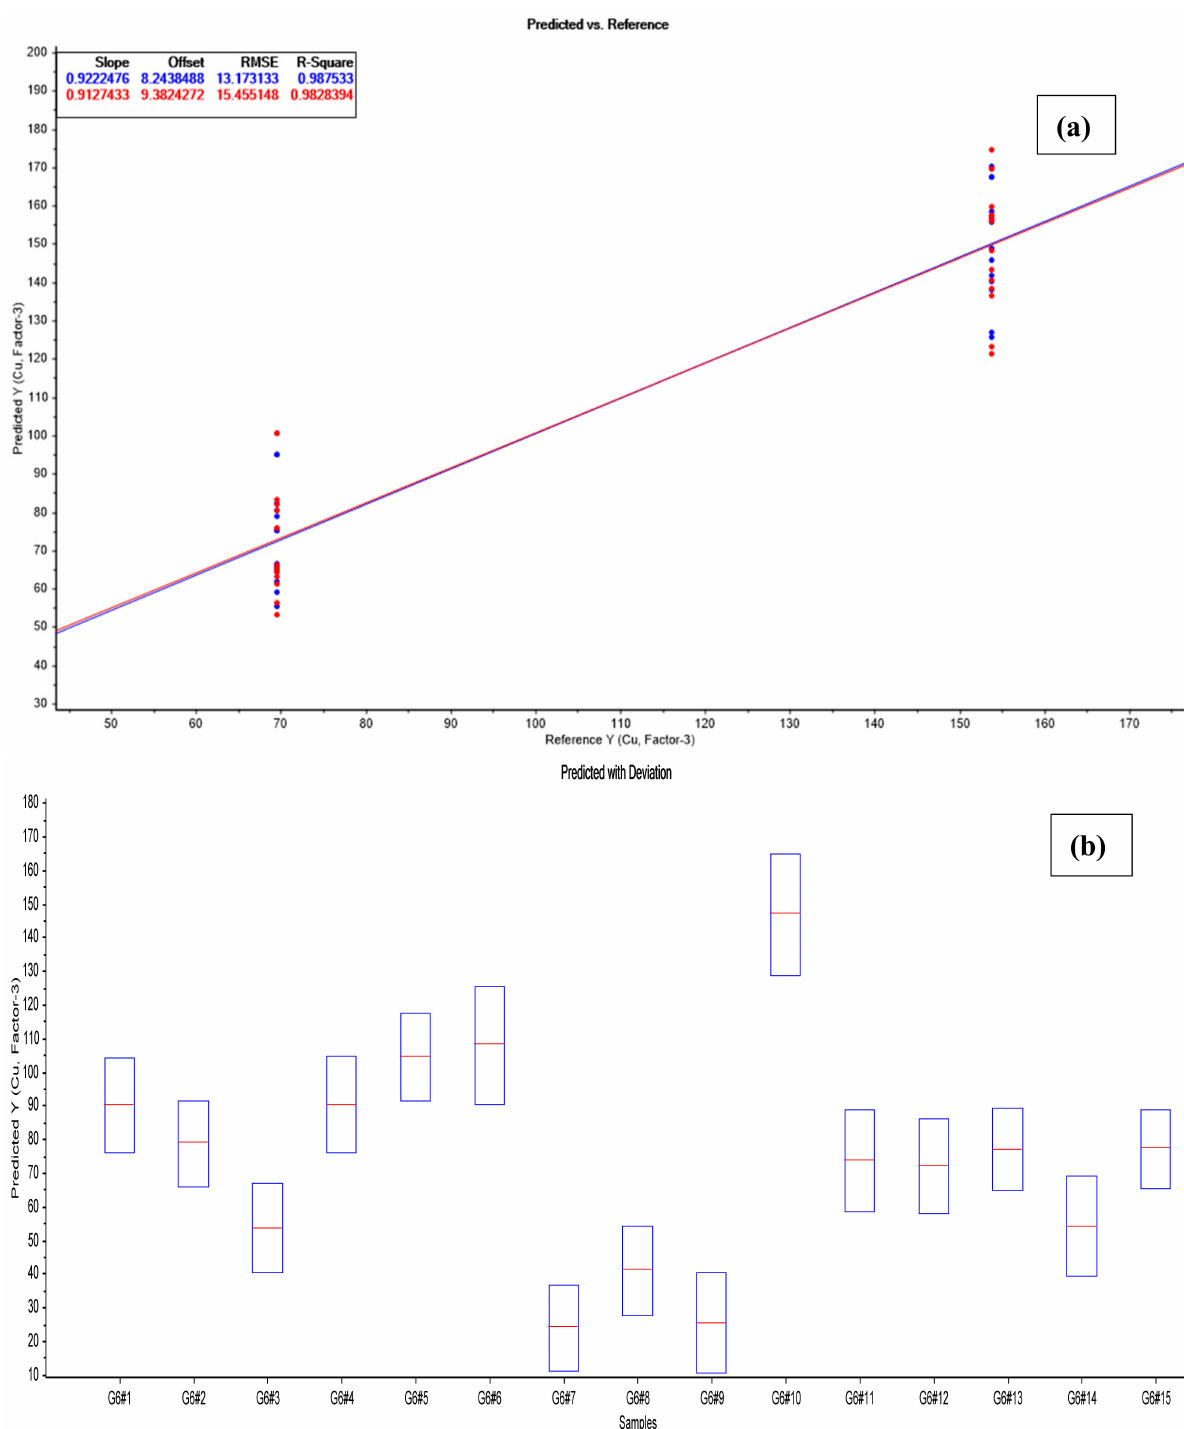
Figure 7. ( a ) Predicted vs. Reference plot of Partial Least Square Regression model ( b ) Prediction of concentration using PLSR